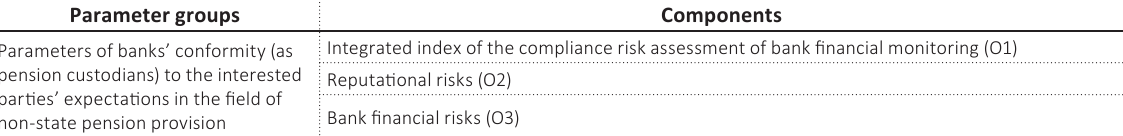
Table 1. Analytical background for modeling banks’ compliance risks (pension custodians) in the field of financial monitoring and their